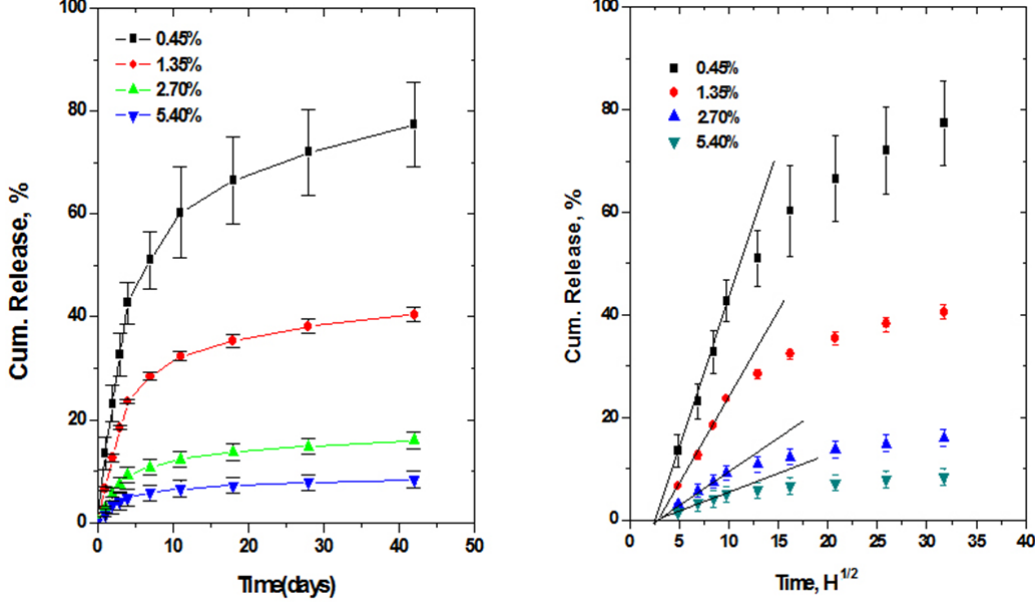
Figure 5. Cumulative release of PTX from a polyurethane (PU) film. A 12-fold increase in the amount of PTX loading into PU film resulted in only two-fold increase in cumulative amount of PTX released from the PU film ( A ) and the cumulative percentage release was inversely proportional to the drug loading ( B ). (Reprinted with permission from [57], Copyright 2010